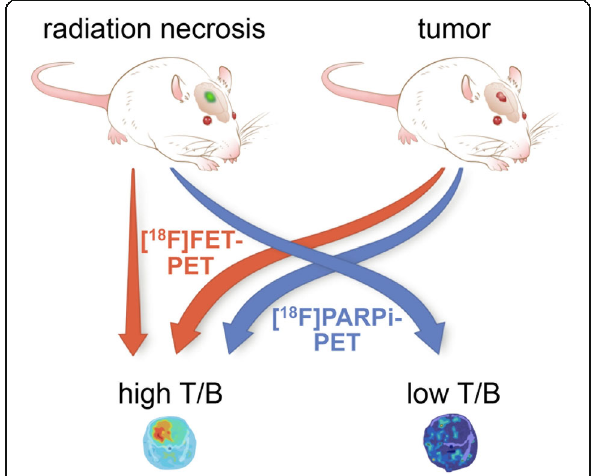
Fig. 1 Experimental setup and hypothesis for imaging radiation necrosis and orthotopic brain tumors with [ 18 F]FET-PET and [ 18 F]PARPi-PET. Due to the molecular properties of each lesion and tracer, [ 18 F]FET-PET will generate high lesion-to-background contrast in both tumor and radiation necrosis, while [ 18 F]PARPi-PET will generate high contrast only in